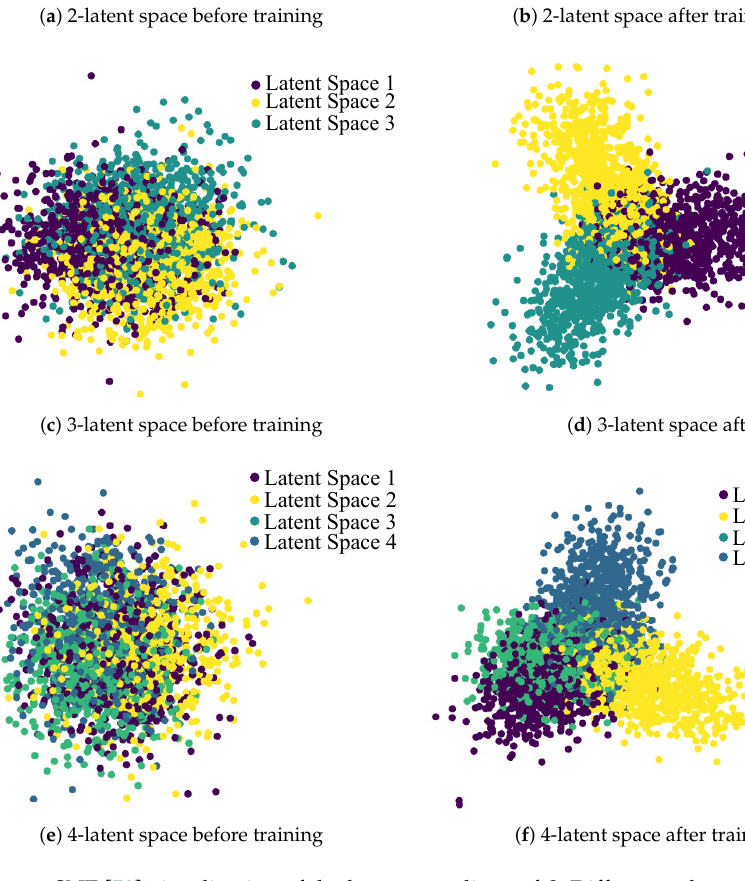
Figure 4. tSNE [50] visualization of the latent encodings of S . Different colors represent generated questions in different latent spaces, and we show the 2-, 3- and 4-latent space cases before and after training. We effectively separate the latent spaces through training. The encodings in different spaces are effectively separated in the 2- and 3-latent space